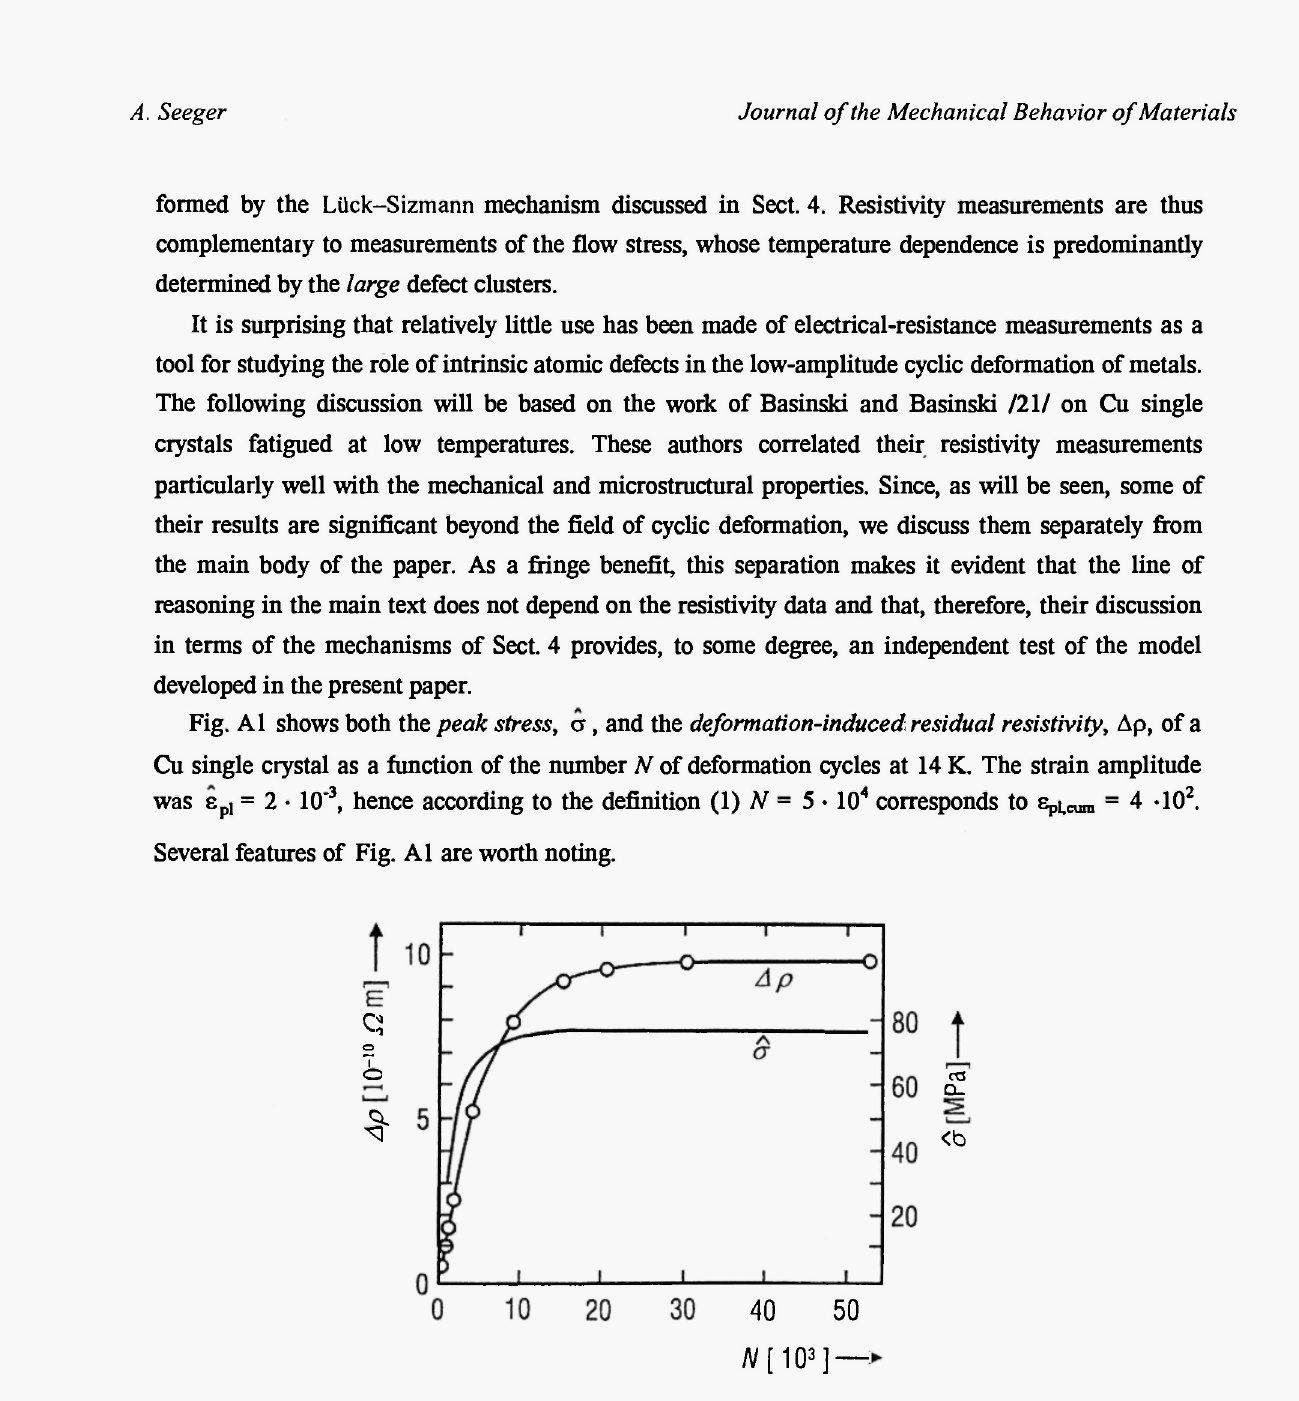
(/) The saturation resistivity Δρ 5 „, = 1 · ΙΟ" 9 Ωιη is rather high. If we assume, for the sake of the argument, that the electrical resistivity per unit atomic concentration of Frenkel pairs is 2.5 • ΙΟ" 6